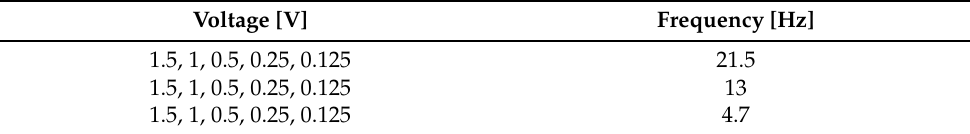
Table 3. Generator’s signal amplitude (voltage) and frequency settings.